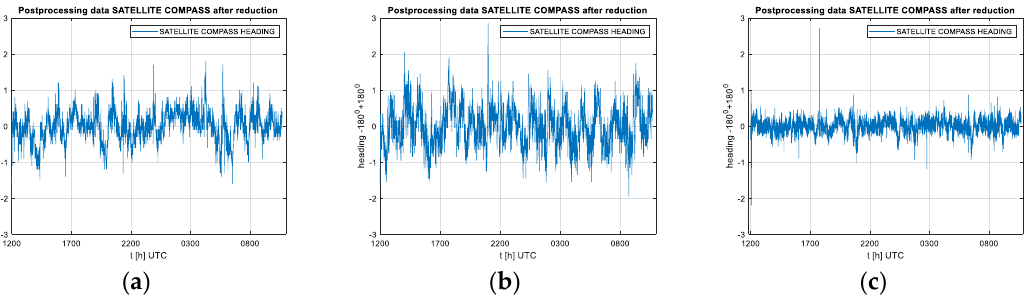
Figure 9. The example subsets of stationary heading registrations by the Advanced Navigation compass ( a ), the Furuno compass ( b ) and the Novatel compass ( c ) (27,28 April 2020). The root mean square of the heading distortion for the Furuno compass is 0.6 degrees, for Advance Navigation is 0.4 degrees and for Novatel is 0.2